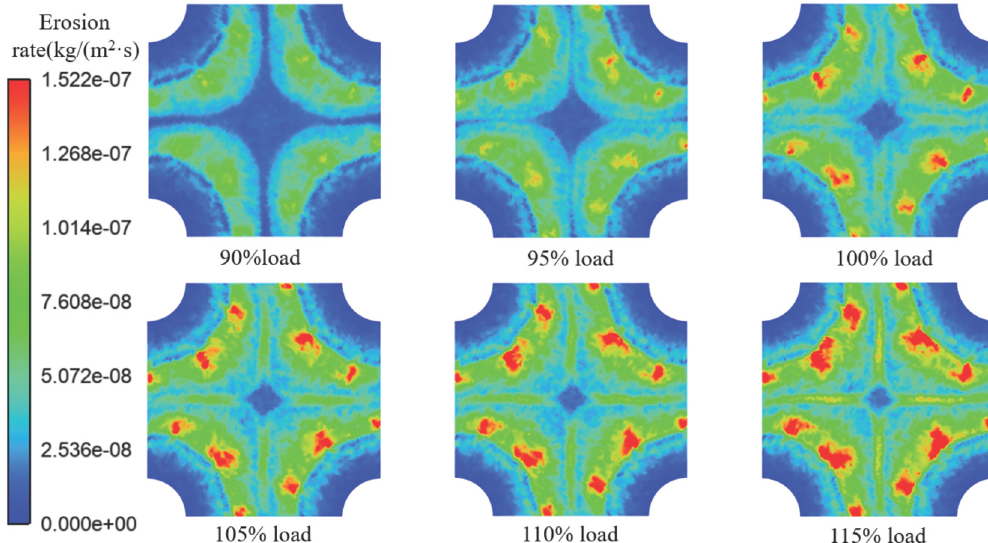
Fig. 9. Cloud diagram of the erosion rate distribution under different loads.